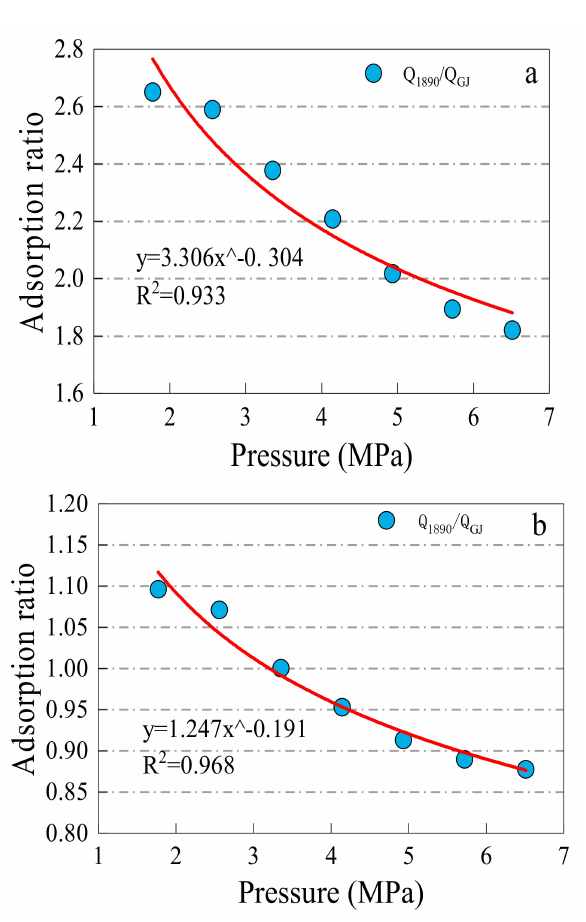
Figure 9. Methane adsorption ratio between adsorption materials and #1890 coal samples in pressure point: ( a ) Q 1890 / Q AA ; ( b ) Q 1890 / Q SG . Note: Q1890, QAA, and QSG indicate the methane adsorption capacity of the #1890 working face coal sample of Aiweiergou, the activated alumina and silica gel,